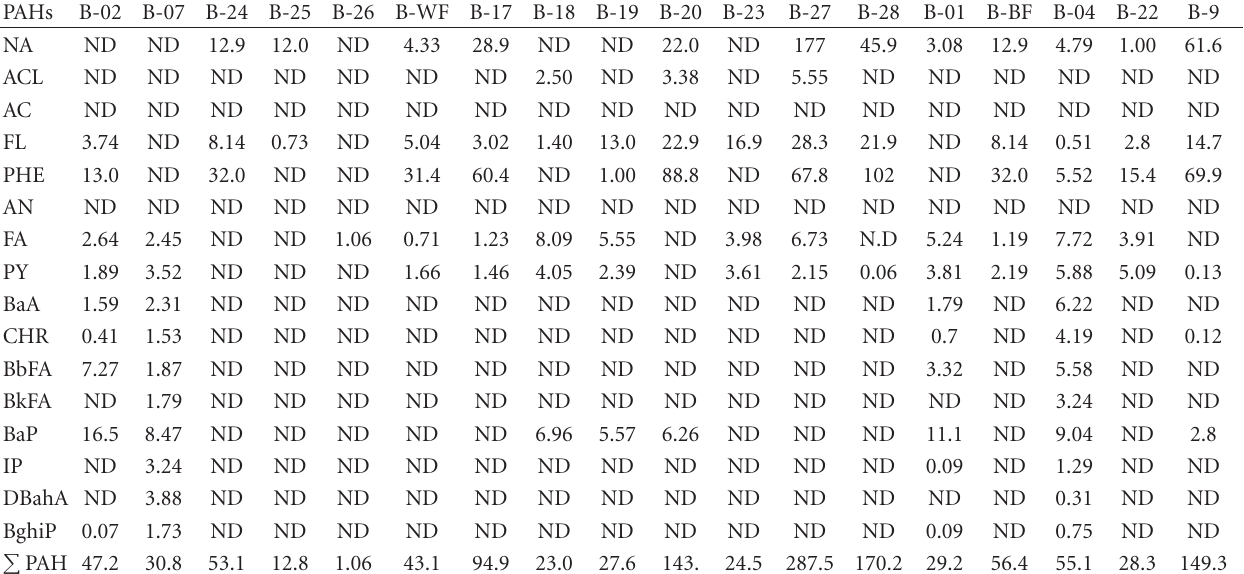
Table 5: Levels of PAHs in bread and flours samples (ng/g), concentration are reported based on duplicate measurements.